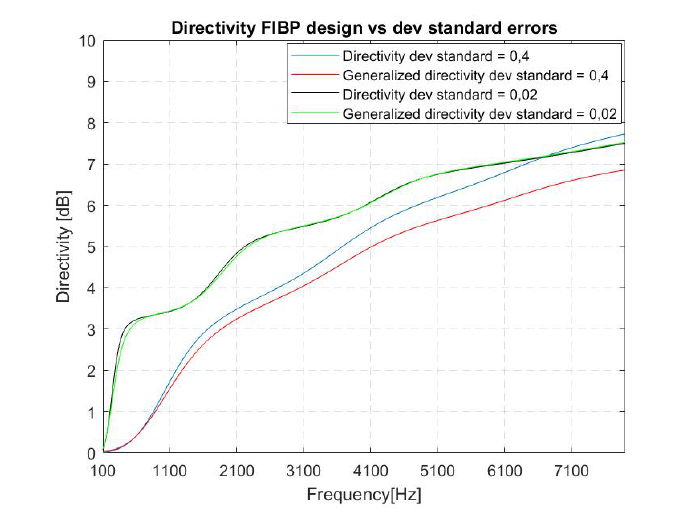
Figure 5. FIBP design: directivity and generalized directivity vs dev standard comparison.